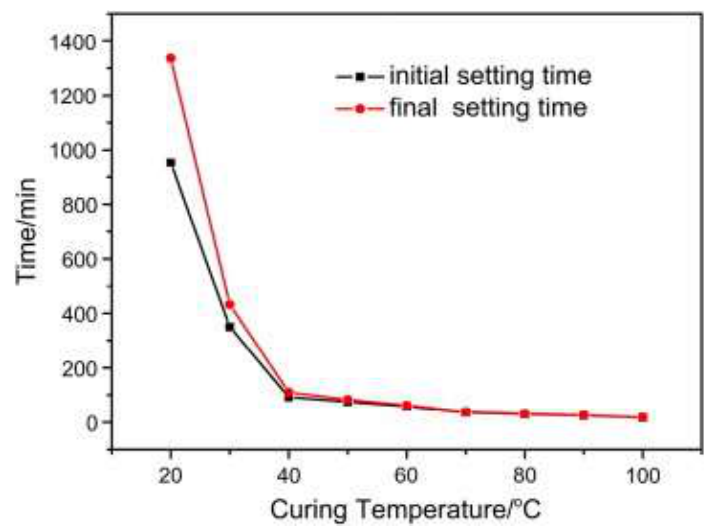
Figure 18. Setting time with temperature [91].